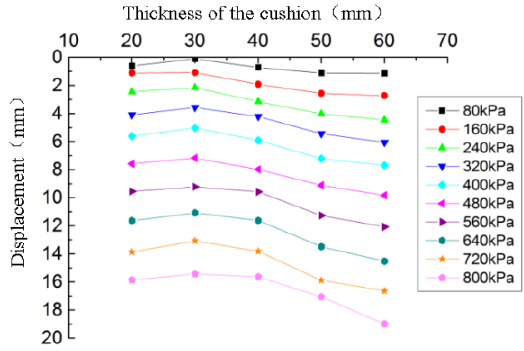
Figure 18. The thickness of the cushion effect on the curve of settlement.